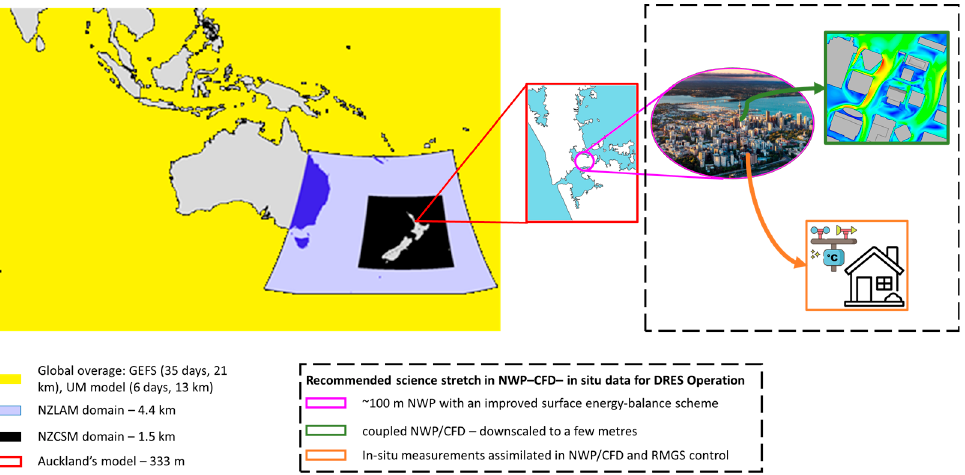
Figure 3. Areal coverage of current NZ’s operational NWP models and our proposed substantial advances in NWP-CFD-in situ data for DRES design and operations.